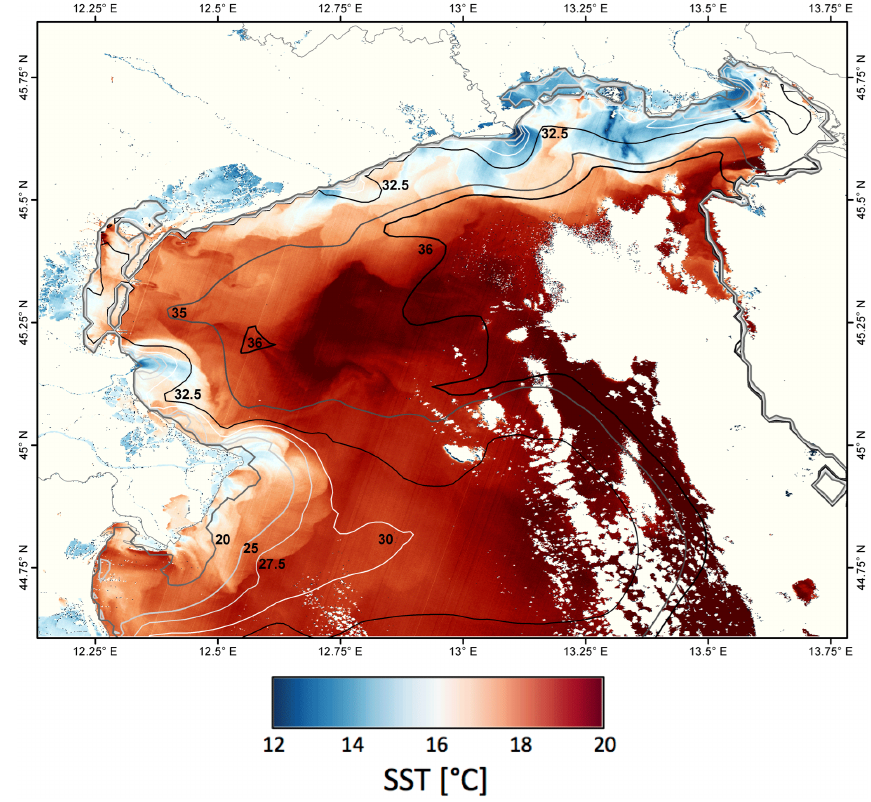
Figure 5. SST field estimated from Landsat 8 TIRS imagery acquired on 19 November 2014. Isohalines from the modelled SSS field are